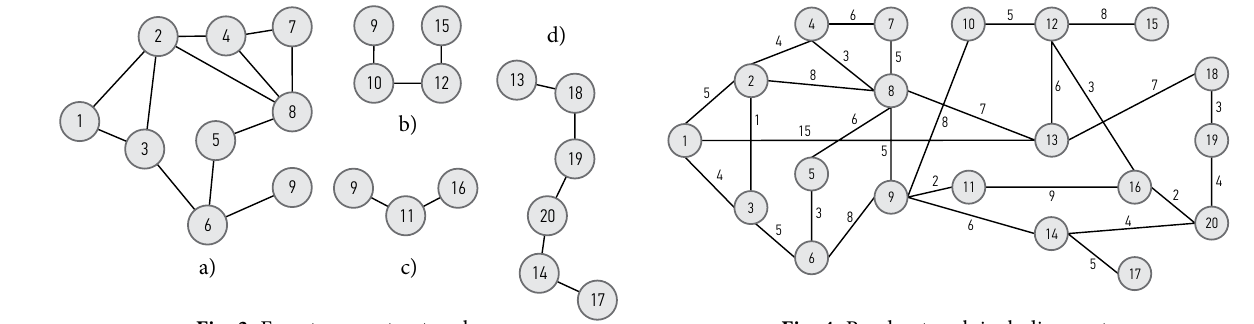
Fig. 3. Four transport networks Fig. 4. Road network including costs